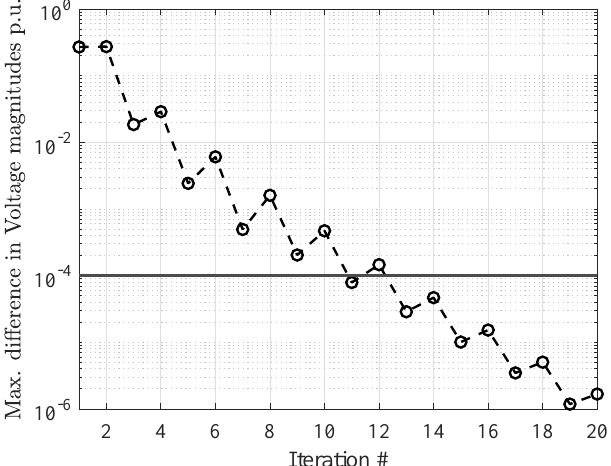
Figure 4. Maximum voltage difference (in magnitude) at each iteration of the proposed